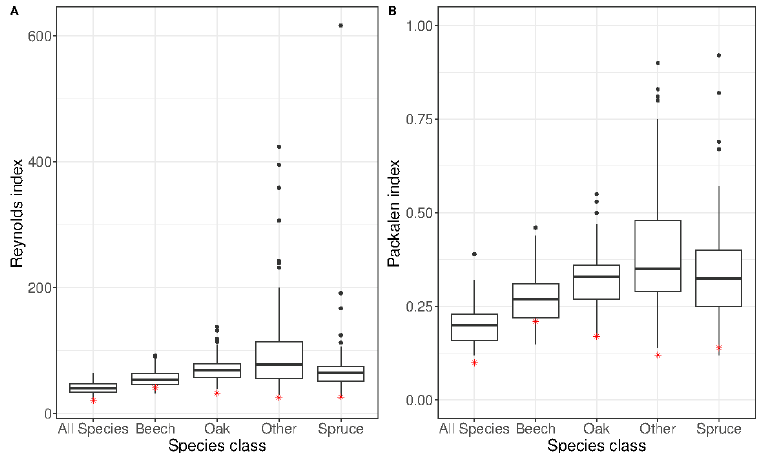
Figure 9. ( A ) Reynold and ( B ) Packalén indices for cross-validation from the 100 replicates, calculated globally (all species) and by species. Red stars correspond to the three component accuracy values for the global NN.